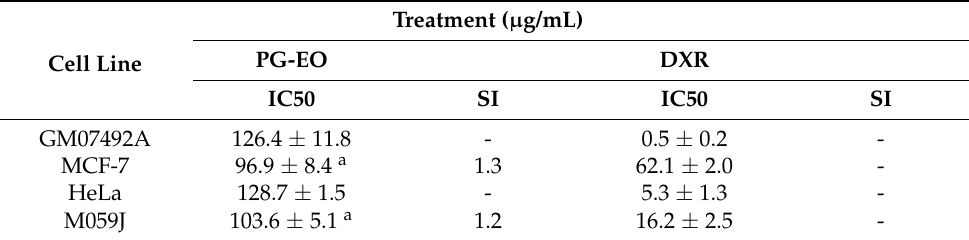
Table 8. IC 50 and selectivity index (SI) of essential oil of P. guajava leaves (PG-EO) against diferent cell